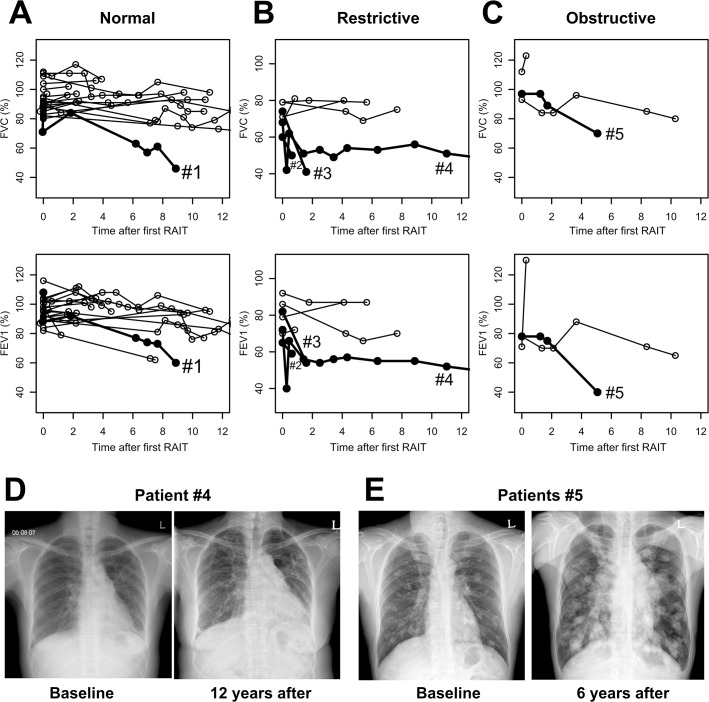
Serial changes in pulmonary function during follow-up after RAIT in patients with pulmonary metastases of differentiated thyroid cancer.Patients were classified according to their baseline pulmonary function. We entered the values of baseline PFT at the time of the first RAIT (time ‘0’) into this figure. (A) Changes in FVC and FEV1 in patients with normal pulmonary function at baseline (n = 21). (B) Changes in FVC and FEV1 in patients with restrictive pulmonary function at baseline (n = 7). (C) Changes in FVC and FEV1 in patients with obstructive pulmonary function at baseline (n = 3). The bold lines indicate the patients who demonstrated a significantly decreased pulmonary function (severe restrictive or obstructive pattern) during follow-up. Each number of the bold lines corresponds to the patient number as shown in Table 2. (D) Patient #4 had mild interstitial lung disease, and chest radiography before RAIT demonstrated ill-defined patch reticular opacities in sub-pleural areas. About 12 years after the first RAIT, her chest radiography showed an increased extent of multifocal patch reticular and ground-glass opacities in peripheral areas of both lungs compared with chest radiography before RAIT. (E) Patient #5 was diagnosed with pulmonary metastases before thyroid surgery and 1-2cm sized multiple metastatic nodules were seen in both lungs on chest radiography before RAIT. The size of the metastatic nodules was increased in follow-up chest radiography even after high-dose RAITs. %, % of measured to predicted values. RAIT, radioactive iodine treatment; PFT, pulmonary function test; FVC, forced vital capacity; FEV1, forced expiratory volume 1 second.